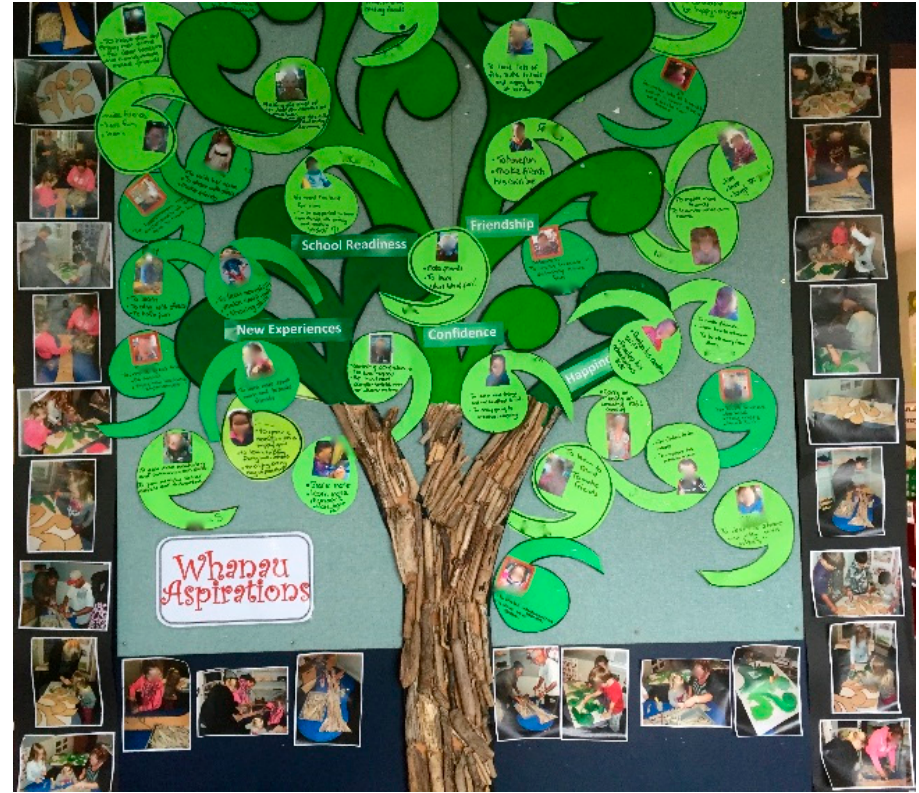
Figure 4. The Wh ā nau Aspirations Tree echoes M ā ori culture. It was co-constructed by centre staff and wh ā nau and set within the ECC’s main learning area. The photos were taken with a digital